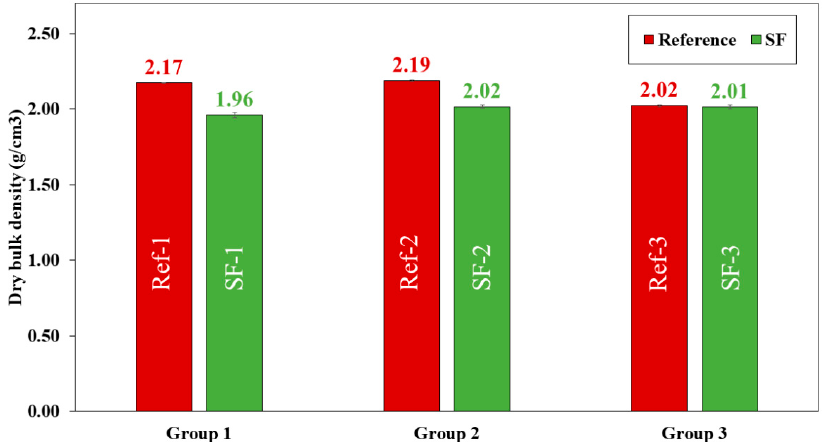
Figure 12. Dry bulk density (g/cm 3 ) of all reference (Ref) and seashell filler (SF) mixtures.